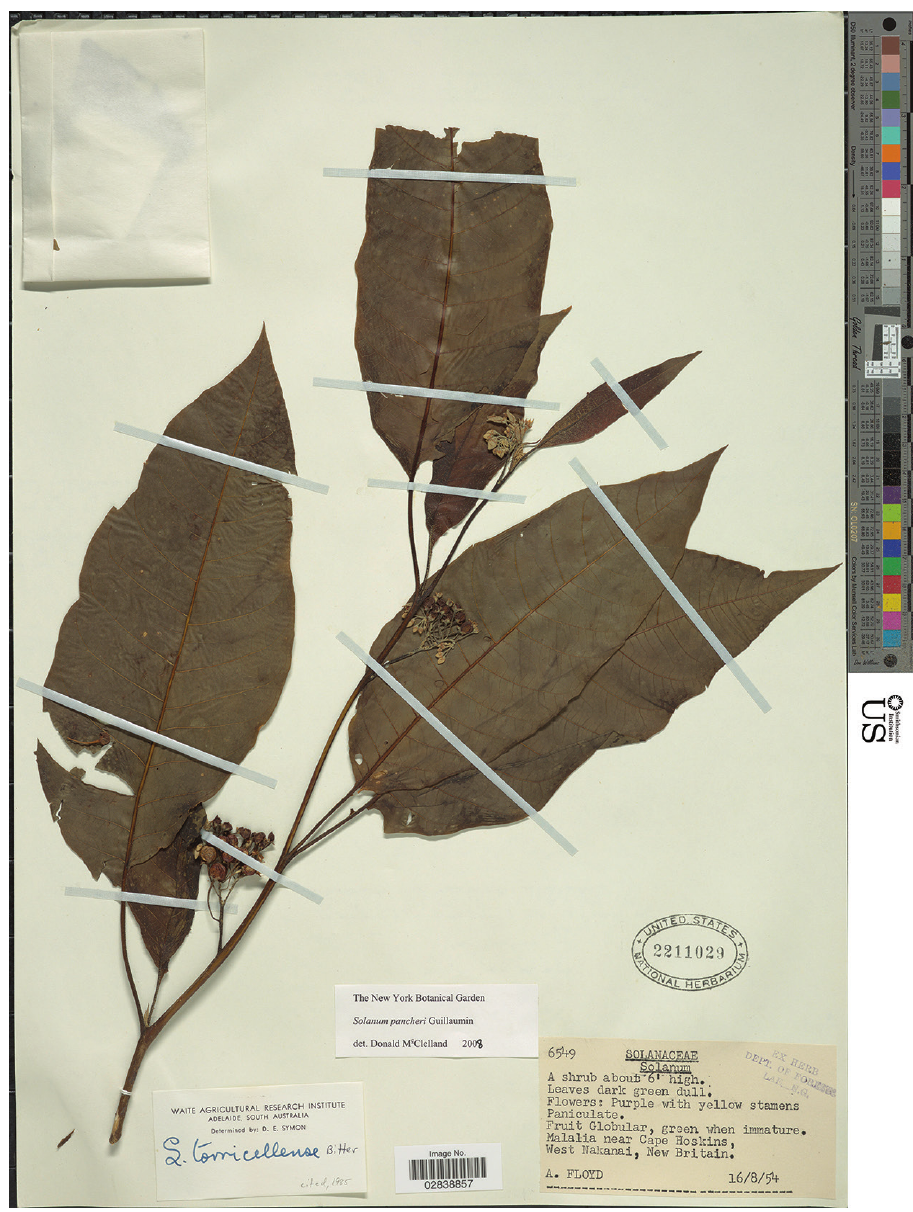
Figure 3. Solanum peekelii Bitter (isoneotype Floyd NGF-6595 , incorrectly labelled as S. pancheri , US [acc. # 2211029, barcode 02838857]). Reproduced with